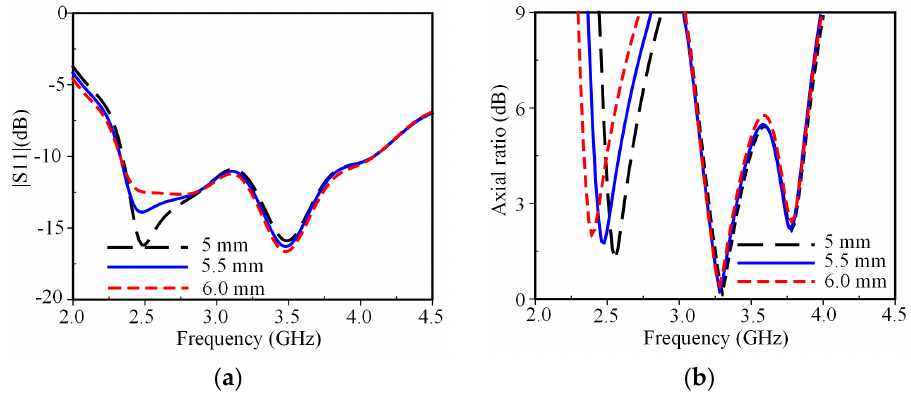
Figure 7. Effect of W 2 on antenna performances: ( a ) S11; ( b ) axial ratio. Figure 7. E ff ect of W 2 on antenna performances: ( a ) S11; ( b ) axial ratio.